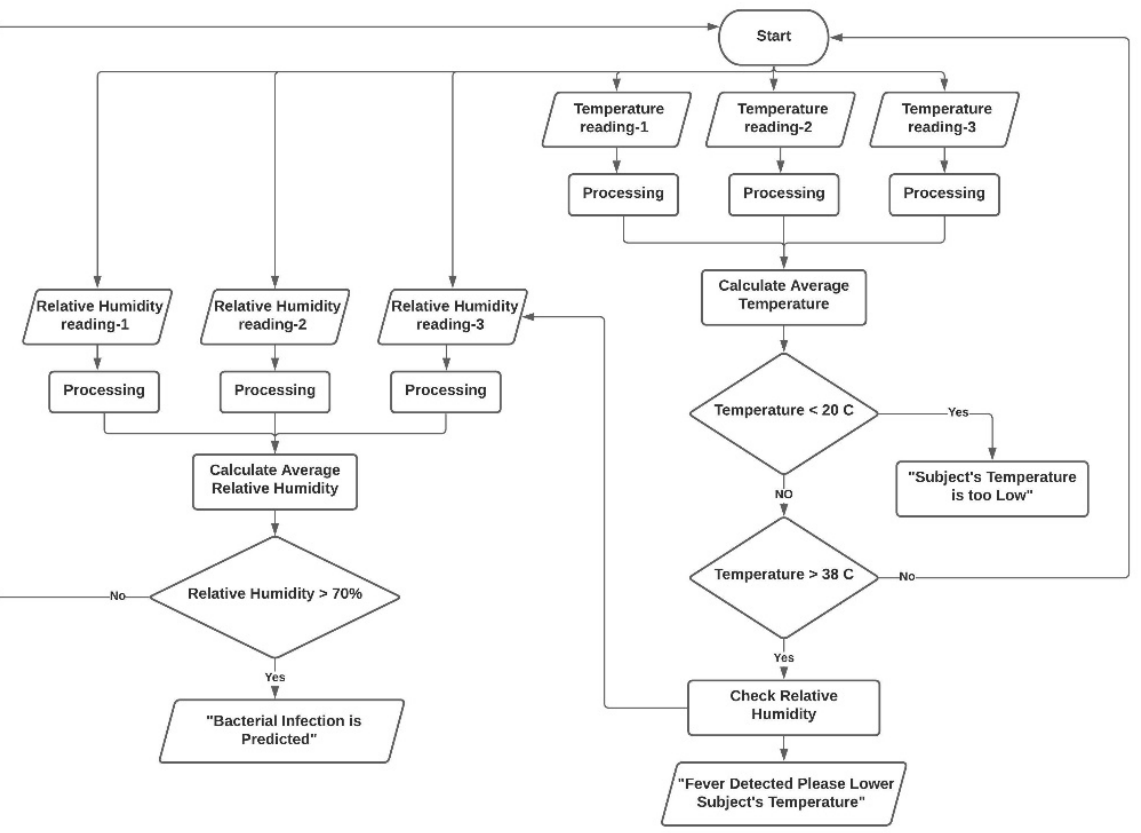
Figure 6. Algorithm structure for prediction of bacterial infection risk .